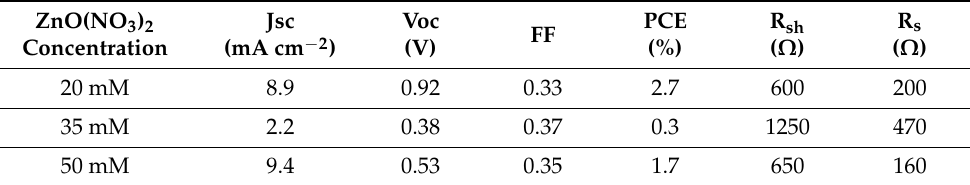
Table 6. Performance of perovskite solar cells (reverse scan) fabricated with the photoanodes of ZnO NWs depending on the [Zn(NO 3 ) 2 ] concentration ([Zn 2+ ]/[PEI] = 4.5; [Zn 2+ ]/[HMTA] = 1.33, growing time of 6 h).